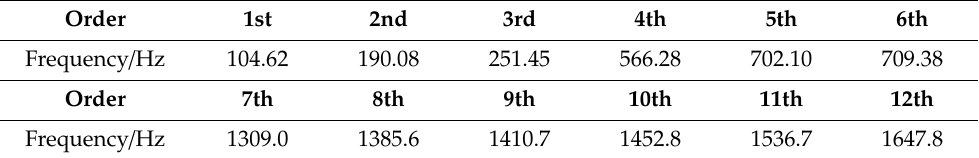
Table 4. Natural frequency of the upper arm in the first 12 order modal